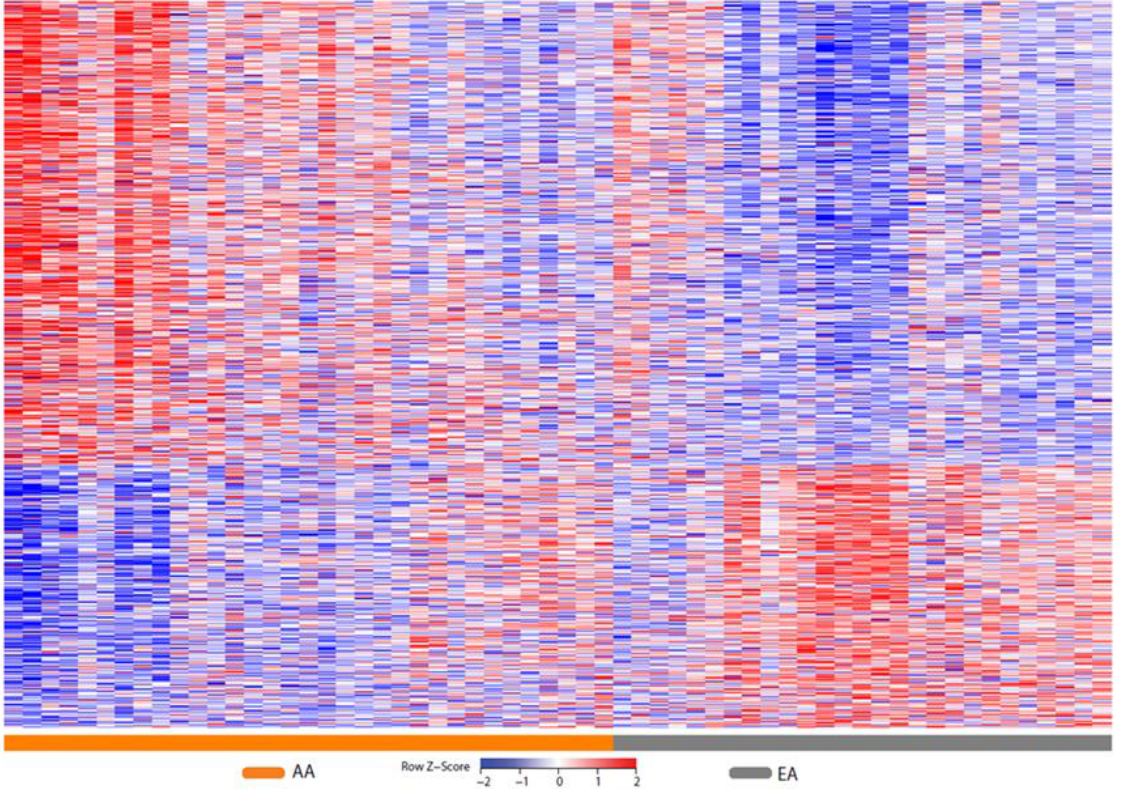
Figure 2. Heat map of gene expression changes by race. Red and blue boxes depict relative over- and under-expression with regard to a reference set as the mid-point between all patients. Only significant transcripts ( q < 0.1) are shown. AA: African – American; EA: European – American.